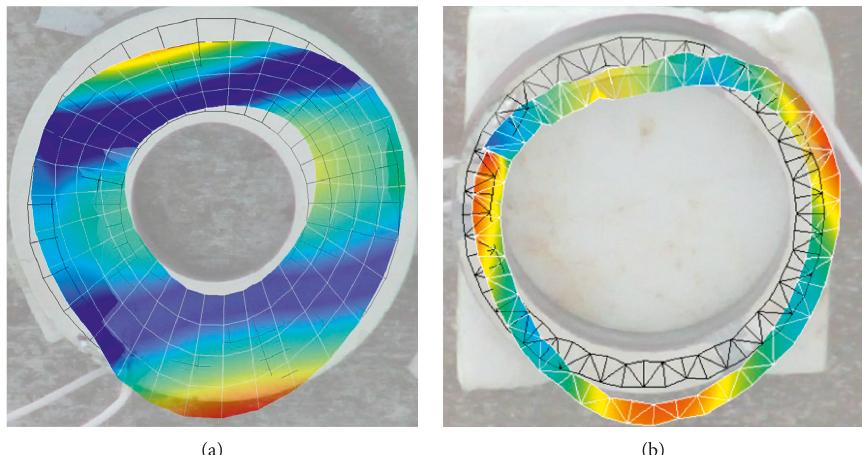
Figure 15: Measured resonance modes of the piezoelectric transducers: ring-type transducer at the frequency of 69 kHz (a), cylindertype transducer at the frequency of 80 kHz(b).